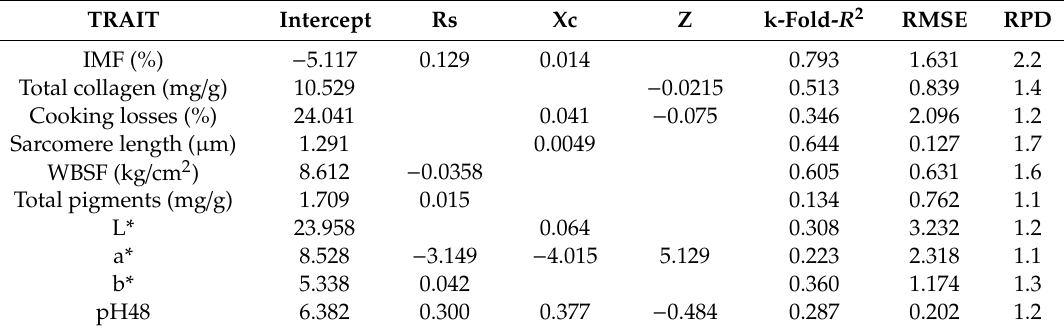
Table 4. Best multiple regression models for predicting longissimus thoracis et lumborum muscle (LM) physicochemical traits (n = 52) 1